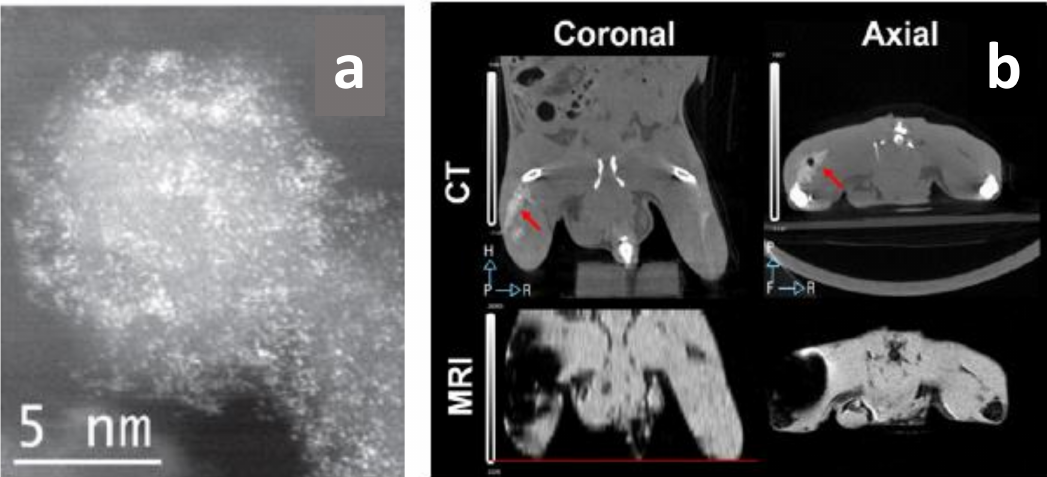
Figure 14. ( a ) STEM HAADF images of FeBi nanocrystals (the bright points correspond to bismuth atoms); ( b ) coronal and axial images taken by CT and MRI after the subcutaneous administration of 100 µ L of FeBi@SiPEG (157 mM Fe and 14.6 mM Bi). The location of the contrast in the left leg of the mouse was marked with an arrow in the CT pictures. The black dot is an air bubble accidentally injected. Adapted with permission from [112], Copyright 2015 IOP Publishing